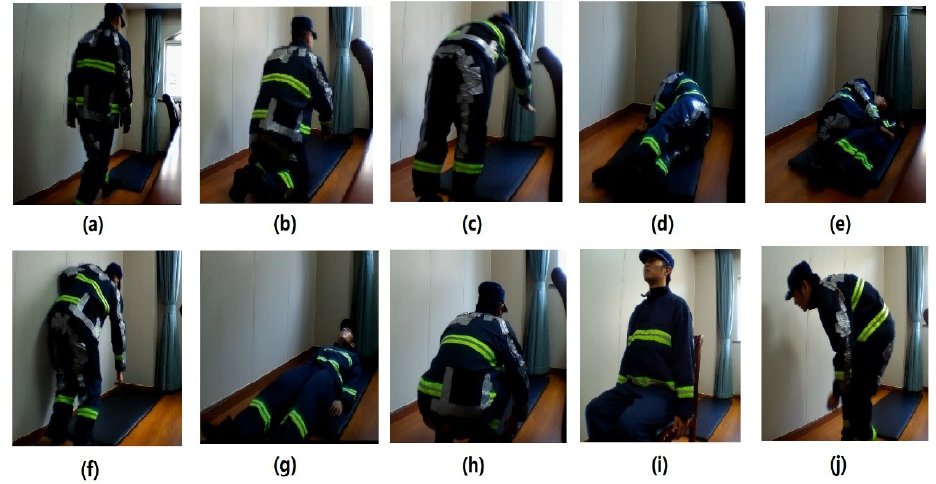
Figure 7. Demonstration of a firefighter with the proposed PJ and PT performing different types of falls and fall-like activities, including ( a ) walking to a mat before falling, ( b ) forward fall with the knees, ( c ) forward fall with the hands, ( d ) left side of an inclined fall, ( e ) right side of an inclined fall, ( f ) slow forward fall with a crouch first, ( g ) backward fall, ( h ) fall-like crouching, ( i ) fall-like sitting, and ( j ) fall-like walking with a